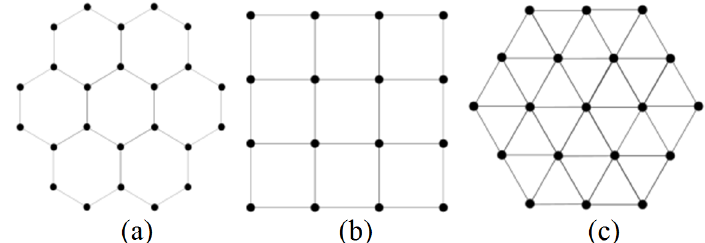
Figure 9. Three antenna topologies for planar arrays. ( a ) Hexagonal tiling. ( b ) Square tiling. ( c ) Triangular